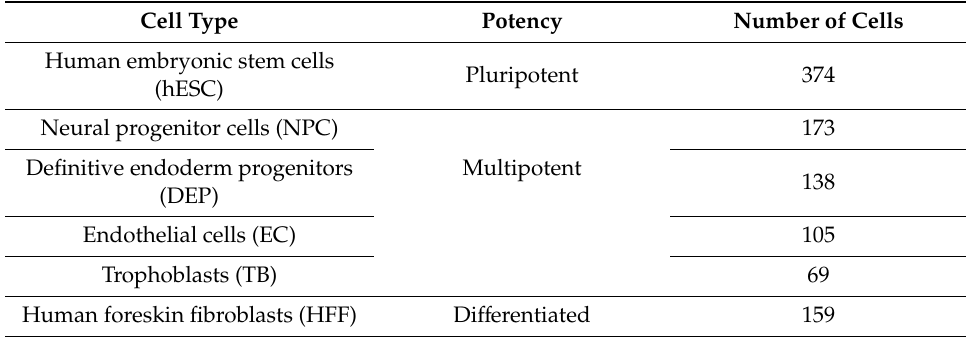
Table 1. The dataset from Chu et al. [20], used in this study, indicating the number of single cells within each cell